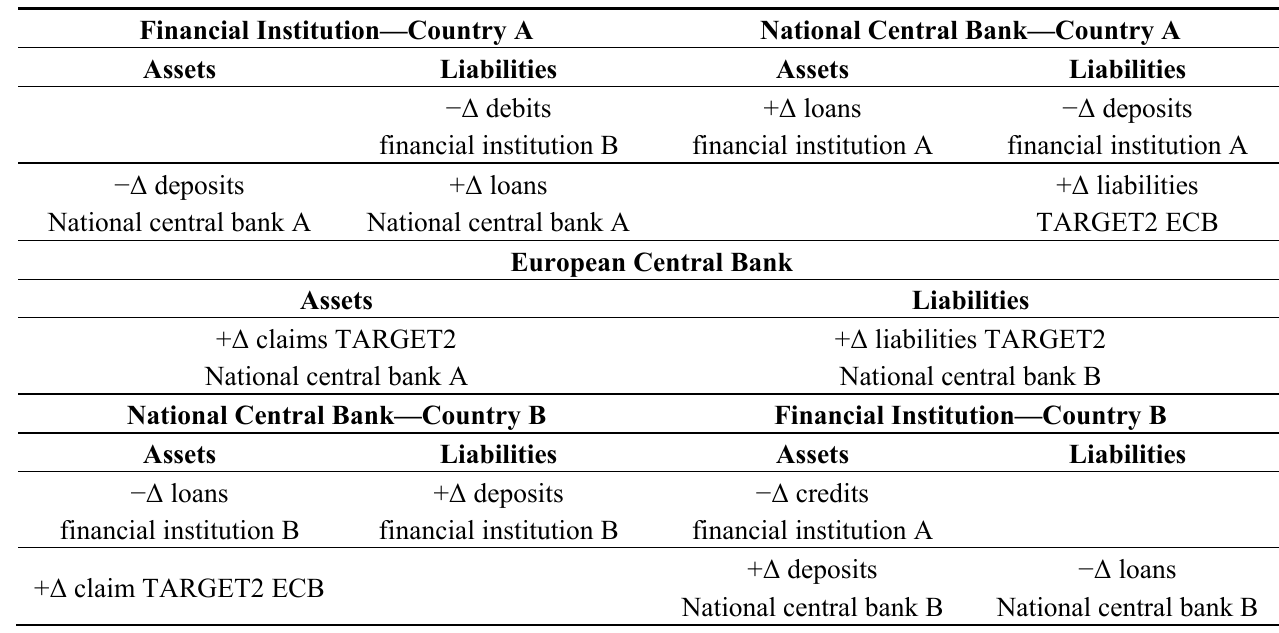
Table 1. TARGET2 system and accounting